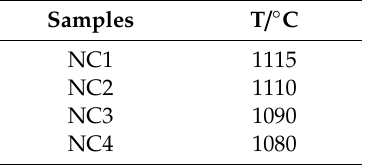
Figure 3. Crack propagation model of TBCs. ( a ) All the layers of TBCs; a detailed view of UNP with predefined cracks; TGO layer; and an SEM image of UNP with microcracks around it; ( b ) various UNCs with predefined cracks. 3. Results and Discussion 3.1. Analysis of Stress Field Distribution The Mises, normal σ 22 and shear stress σ 12 distribution of TC in NC1–NC4 coatings are in Figure 4. From Figure 4, all the types of stresses are highly dependent on the surface roughness of BC/TC interface or UNP/crystalline region’s interface. For the mises stress in Figure 4a, due to the loose distribution structure, low elastic modulus and low density, thermal stress inside the UNPs presented the lowest value, thermal stress inside the UNPs presented the lowest value (blue area, 150–317 MPa) and the stress in the vicinity of the unmelted nano-particle was higher (green area,